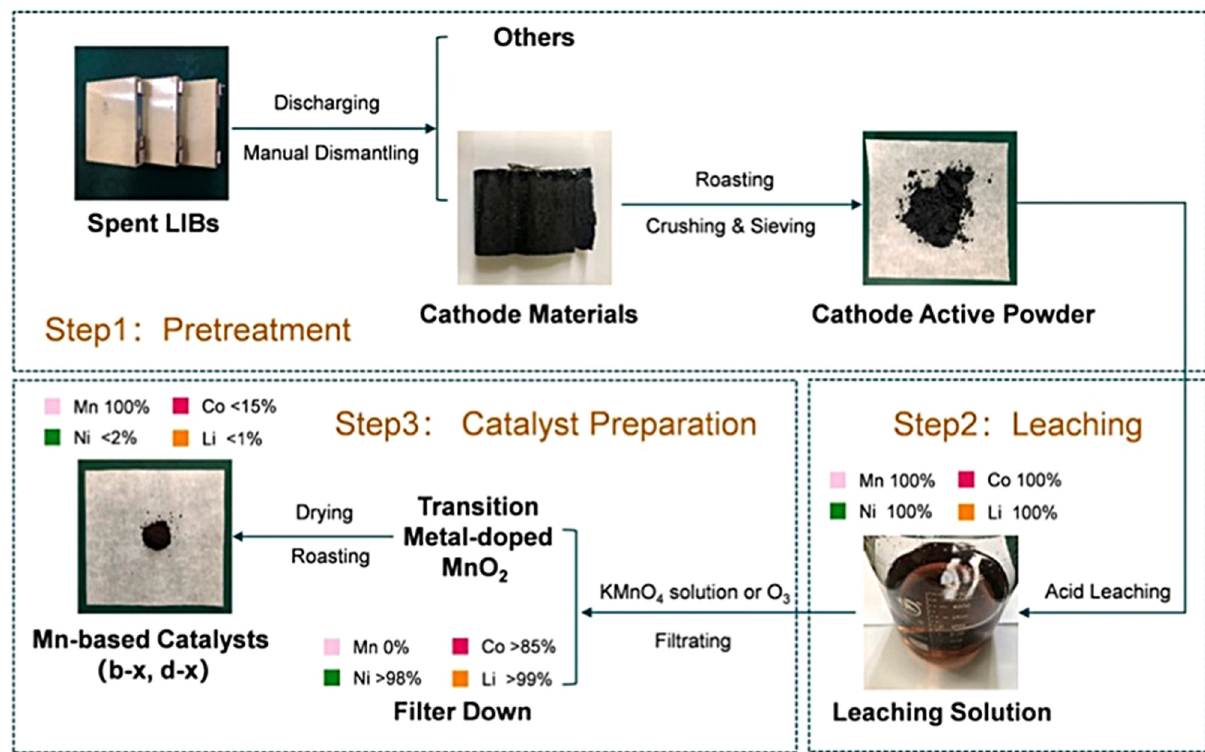
Figure 18: Schematic with photographs of MnO 2 fabrication from spent LiBs. Copied with permission from ref. [ 221 ] ; Elsevier,